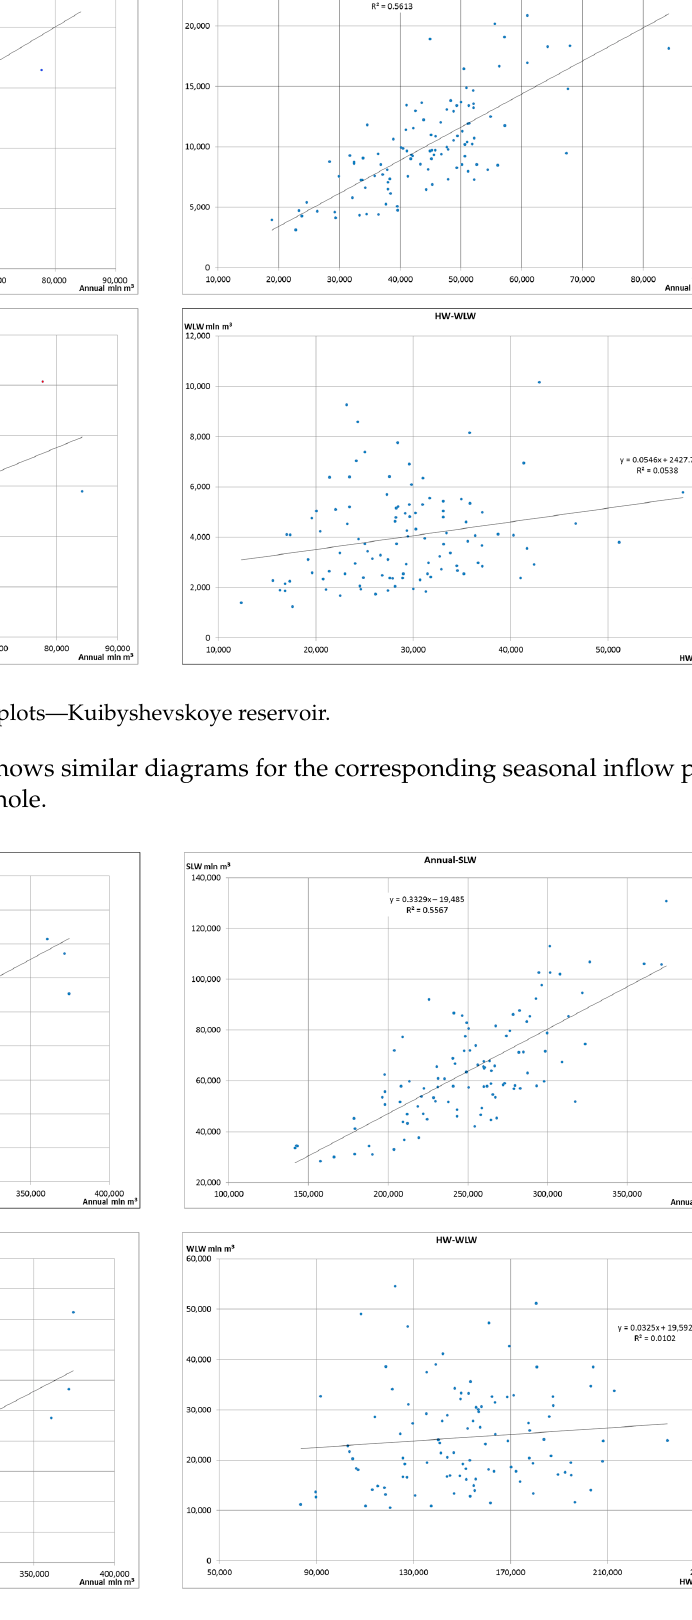
Figure 7. Sca tt erplots—VKC. Figure 7. The fi rst three diagrams in both fi gures demonstrate the presence of su ffi ciently ex- pressed statistical relationships between the respective series of in fl ows. The last diagram (HW–WLW) shows the lack of correlation between high-water in fl ow and winter low- water in fl ow. A quantitative assessment of the correlation dependences of the annual and seasonal in fl ows of the Kuibyshevskoe reservoir (KR) and the VKC in the form of the pairwise correlation coe ffi cients is given in Tables 5 and 6, respectively. Table 5. The correlation coe ffi cients—KR. Annual